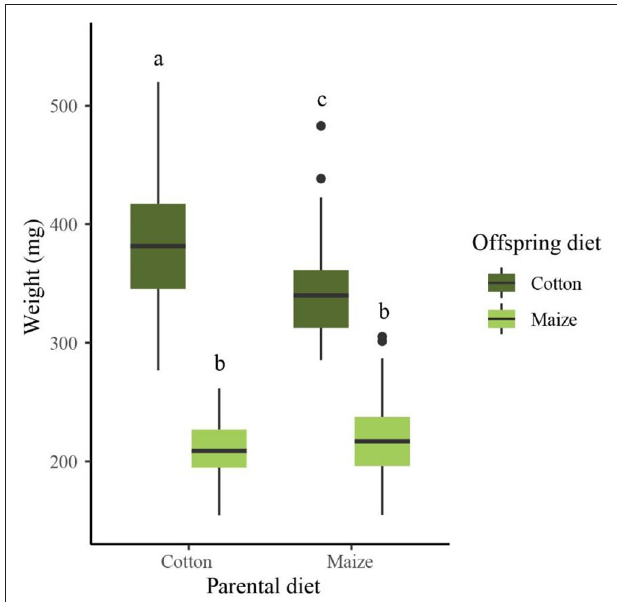
FIGURE 5 | Pupal weight of larvae reared on maize (light green boxes) and cotton (dark green boxes) of parents reared on either a matching or mismatching diet. Boxplots show means (black lines) and 25–75% percentiles. Whiskers show data ranges, excluding outliers (black circles, defined as values more than one box length from the upper and lower edges of the corresponding boxes). Different letters indicate significant between-treatment differences (LM, Tukey’s HSD test, P <